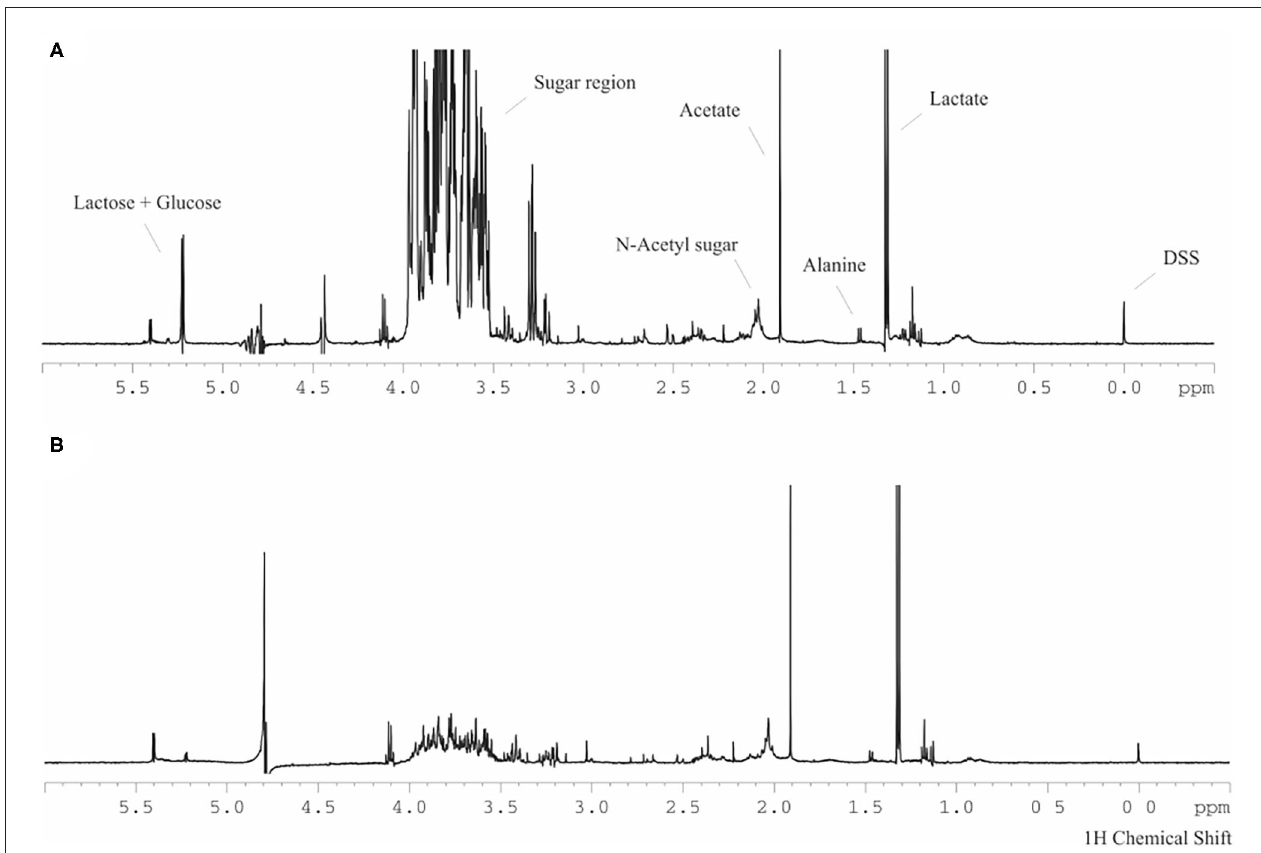
FIGURE 3 | Representative ¹H NMR spectrum of whole saliva from infants in the pre-dental period with exclusive breastfeeding before (A) and after cleaning their oral cavity (B)